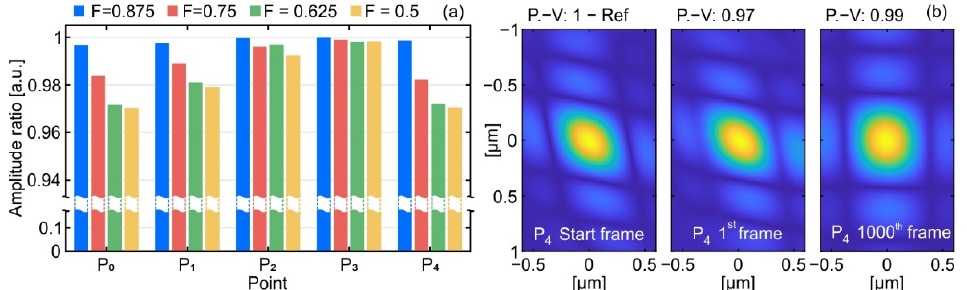
Figure 5. ( a ) Accuracy test of points distributed along the diagonal of image space for different overlap sizes after a single hologram update cycle; ( b ) reconstructed point P 4 from the starting hologram, first and thousandth hologram obtained with proposed update method.